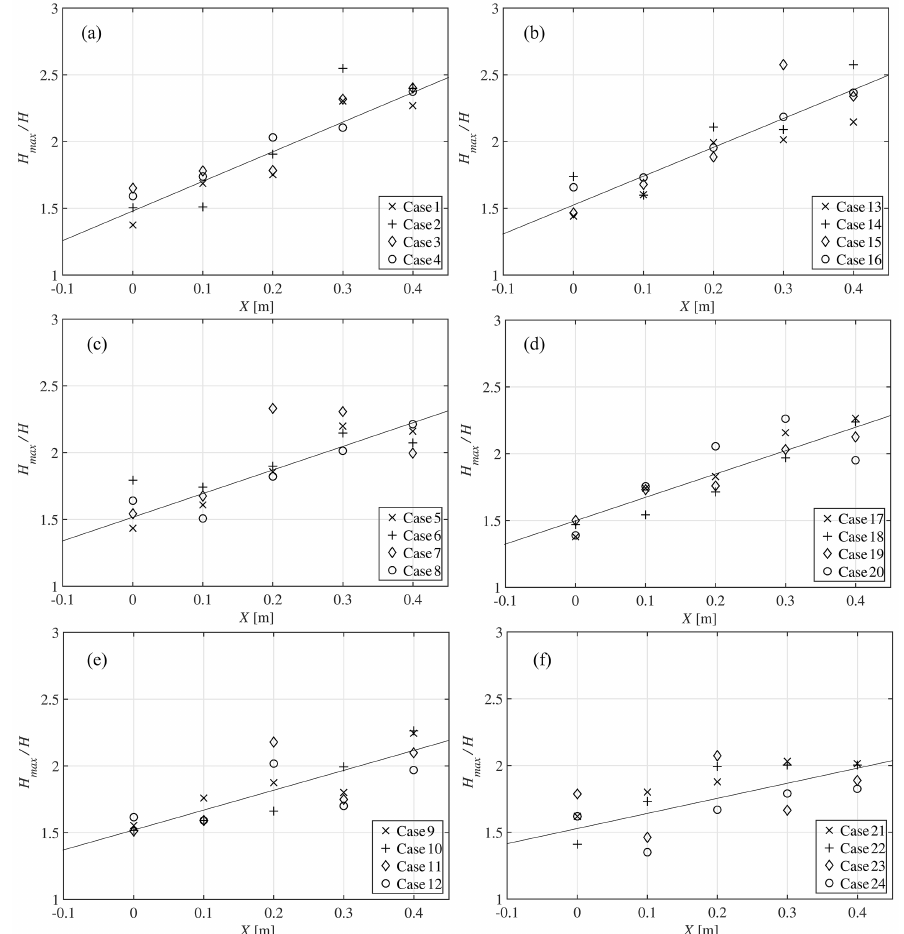
Figure 8. Maximum relative wave height in front of the cliff in Tank 2: (a) and (b) H = 0.04m; (c) and (d) H = 0.05m; (e) and (f) H = 0.06m.